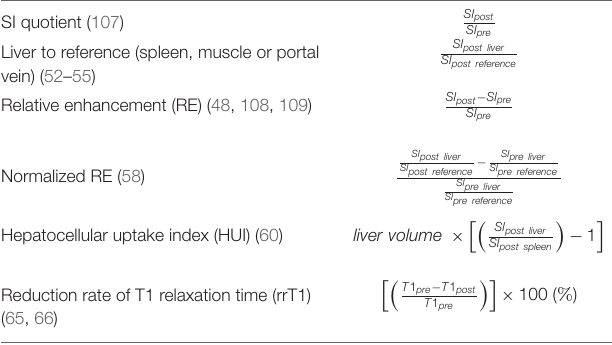
suggested that the degree of enhancement may reflect liver cellular function